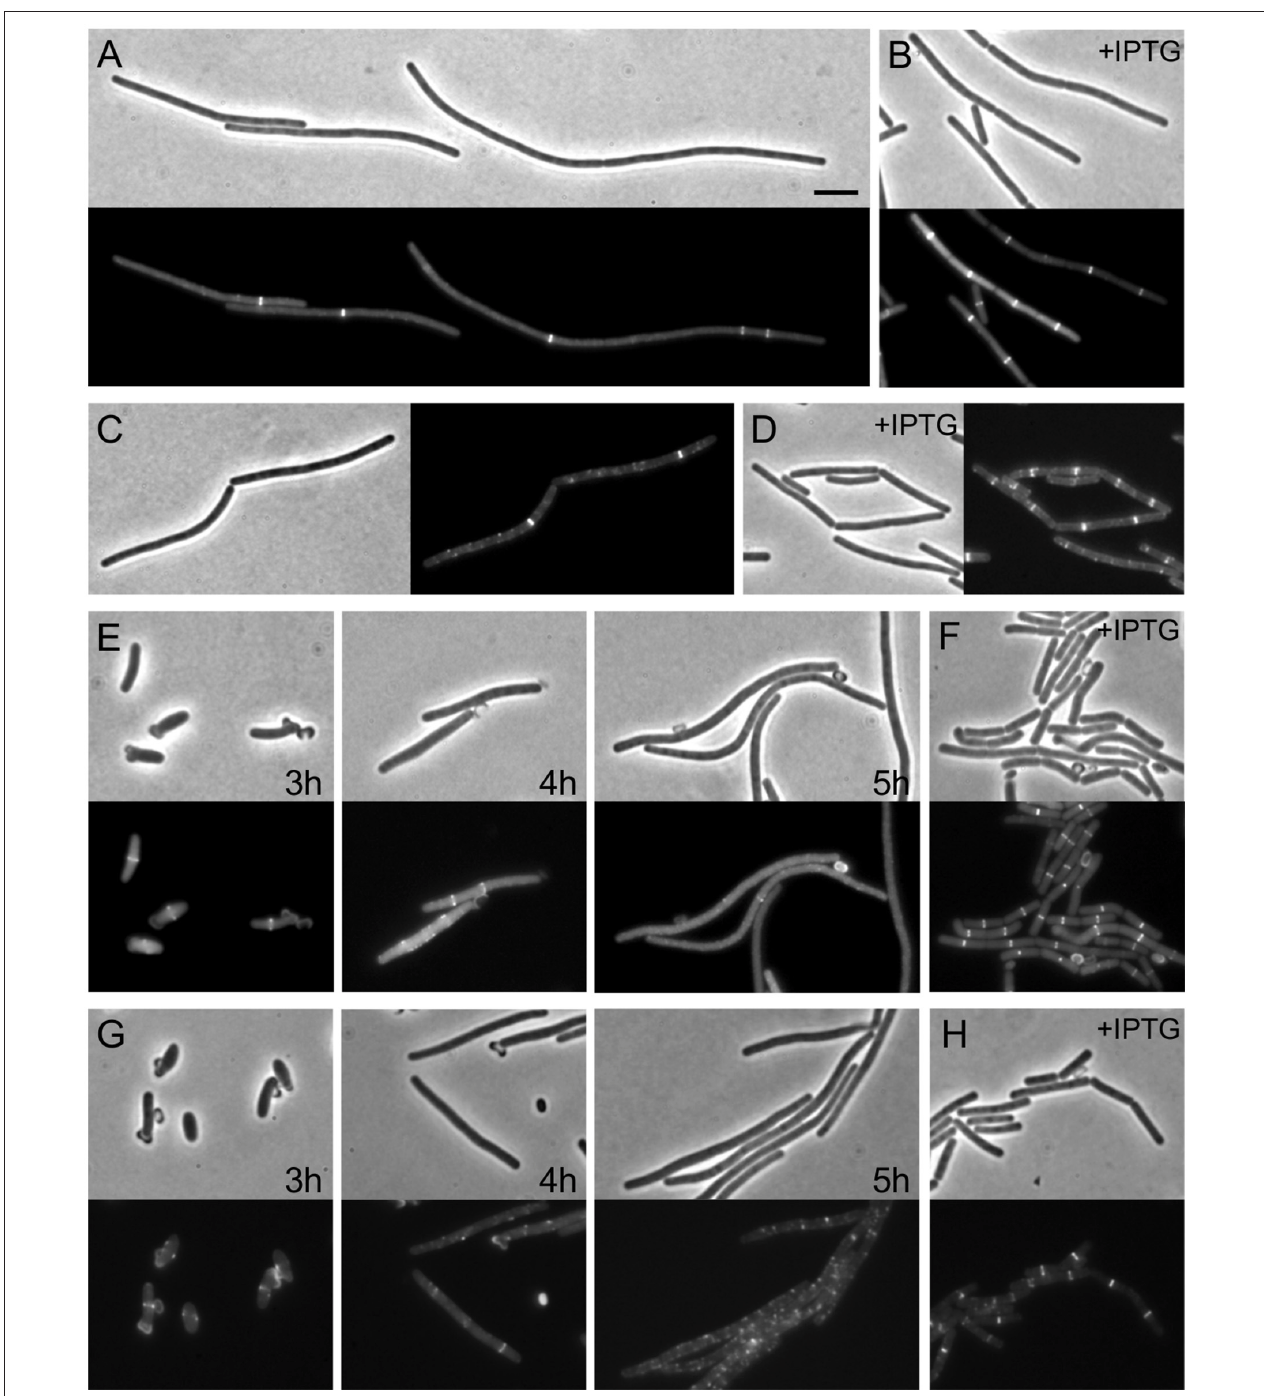
FIGURE 1 | Assembly of Z-rings after depletion of FtsW. (A,B) Localization of FtsZ in FtsW depleted cells. Strain PG80 ( P spac -ftsW; amyE :: Pxyl-gfp-ftsZ ) was grown in competence medium at 37 ◦ C in the absence (A) or in the presence (B) of 1 mM IPTG. Depletion of FtsW was achieved by diluting cells in warm medium in the absence of the inducer. Phase contrast and GFP images were taken after 8 h of depletion ( ∼ 14 generations). (C,D) Localization of EzrA in FtsW depleted cells. Strain PG82 ( P spac -ftsW; ezrA-gfp ) was grown in competence medium at 37 ◦ C in the absence (C) or in the presence (D) of 1 mM IPTG. Depletion of FtsW was achieved by diluting cells in warm medium in the absence of the inducer. Phase contrast and GFP images were taken after 6 h of depletion ( ∼ 10 generations). (E–H) Localization of FtsZ and EzrA in FtsW depleted germinating spores. Spores of strain PG80 (E) or PG82 (G) were heat shocked as described and germinated at 37 ◦ C in the absence of IPTG. Phase contrast and GFP images were taken after 3, 4, and 5 h, respectively. (F–H) Spores of strain PG80 (F) or PG82 (H) after 5 h of germination in the presence of 1 mM IPTG. Scale bar: 5 µ m.